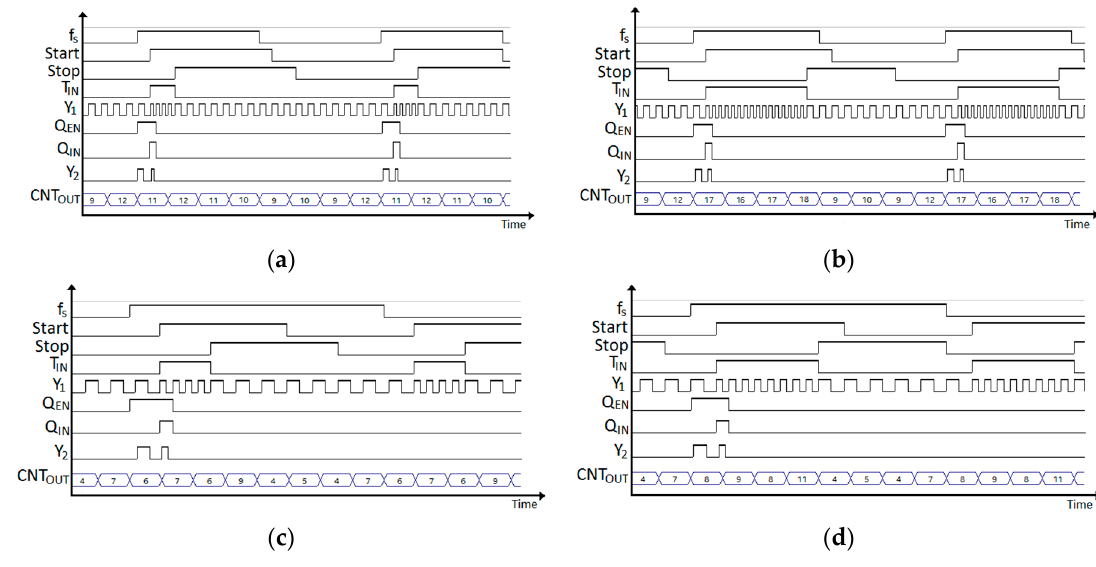
Figure 6. Timing diagram of the proposed 1-1 MASH multirate TDC: ( a ) f S1 = 200 MHz and f S2 = 800 MHz with T IN = 1 ns; ( b ) f S1 = 200 MHz and f S2 = 800 MHz with T IN = 4 ns; ( c ) f S1 = 400 MHz and f S2 = 1600 MHz with T IN = 1 ns; ( d ) f S1 = 400 MHz and f S2 = 1600 MHz with T IN = 2 ns.